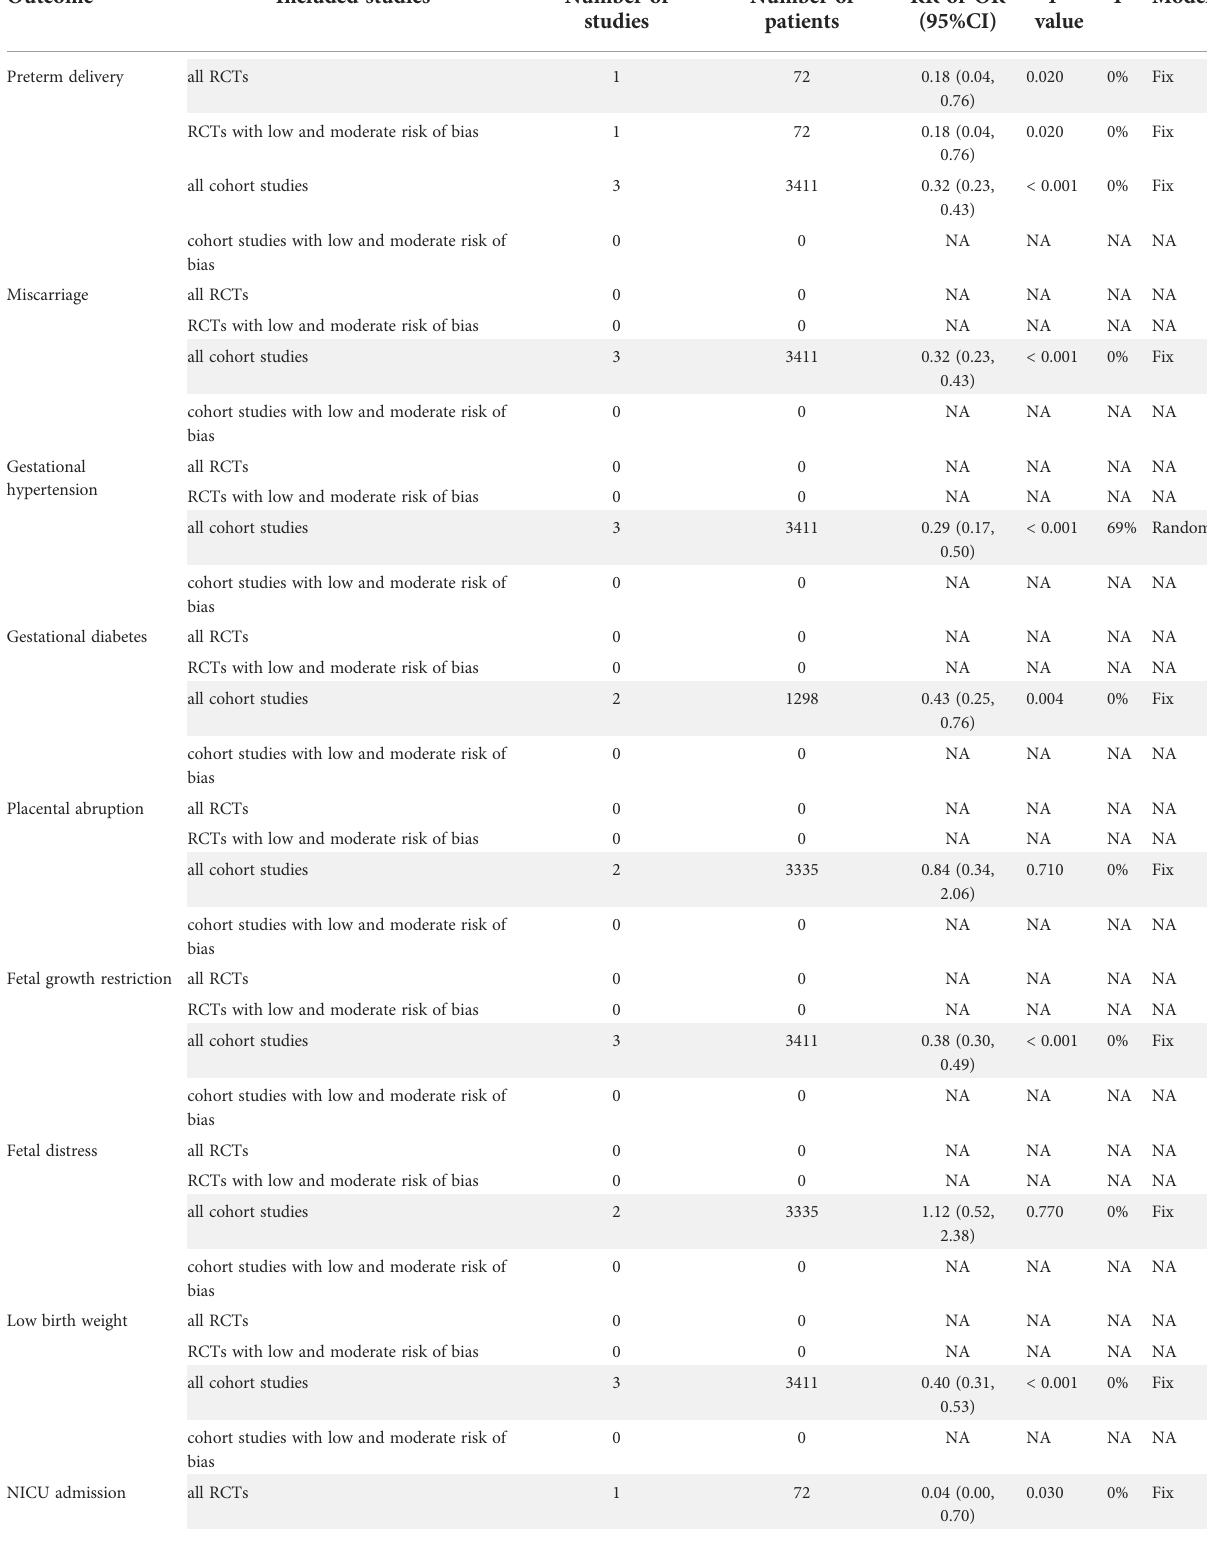
TABLE 2 Meta-analysis results of the TPOAb-positive